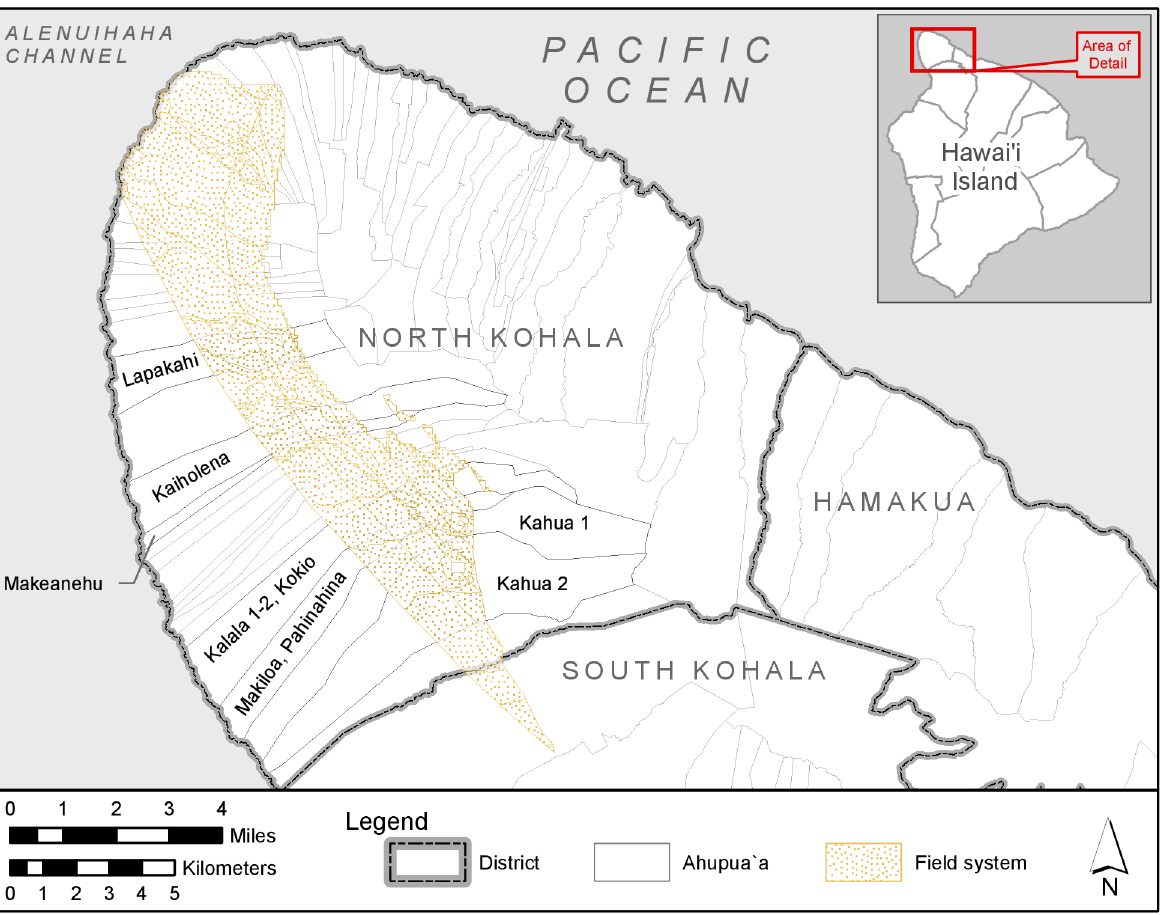
Figure 1. Location of the leeward Kohala field system. Also shown are the contact-era land divisions known in Hawai’i as ahupua’a . Ahupua’a land divisions where archaeological research in the leeward Kohala field system has concentrated are labeled.